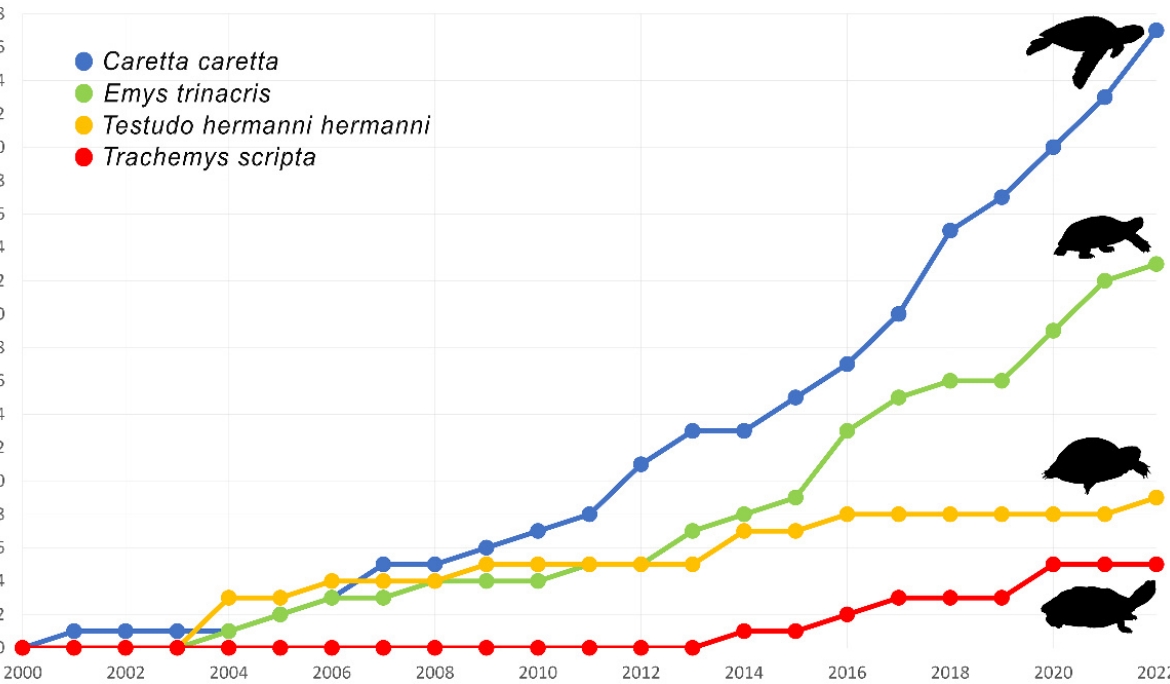
Figure 2. Cumulative curves of a scientific paper on Sicilian Testudines from 2000 onwards.